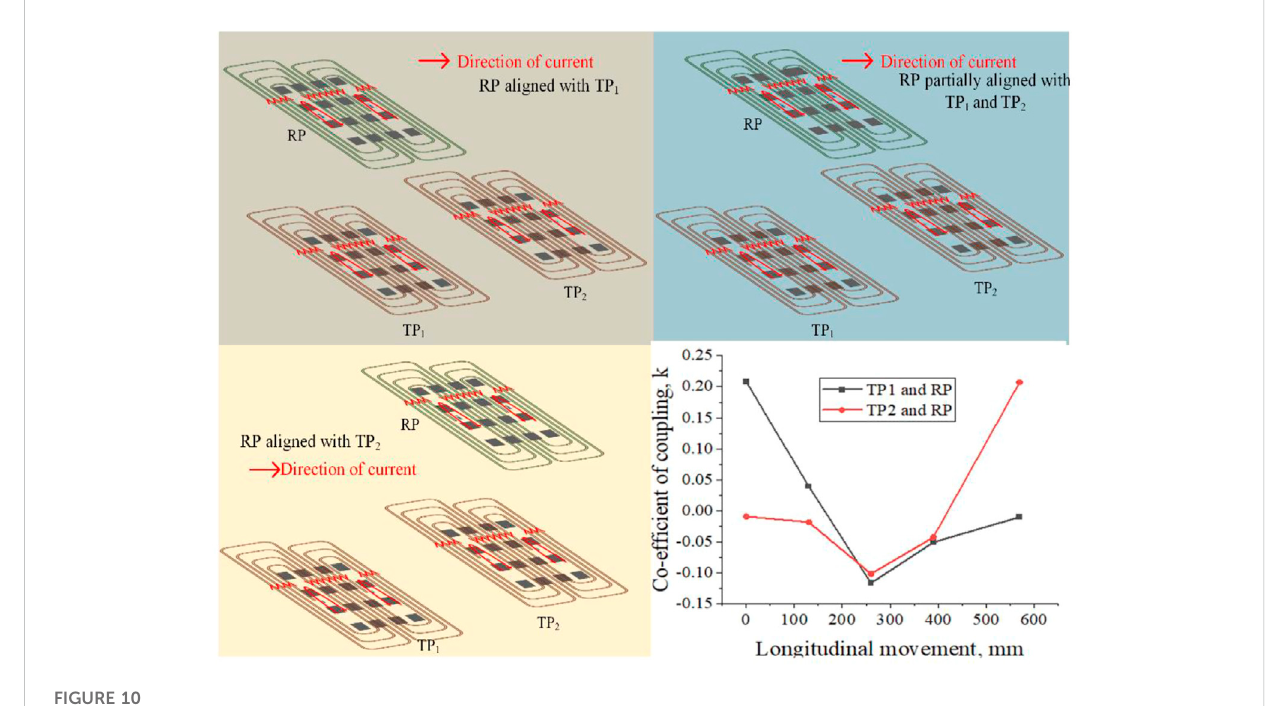
FIGURE 10 Variations of k concerning the